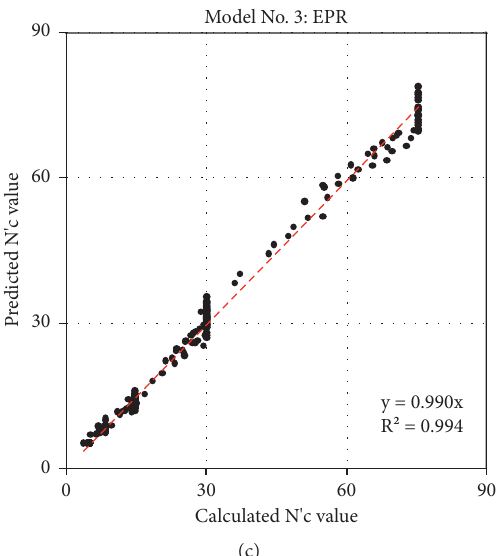
Figure 3: Relation between the predicted and calculated N ′ c values using the developed (a) GP, (b) ANN, and (c) EPR